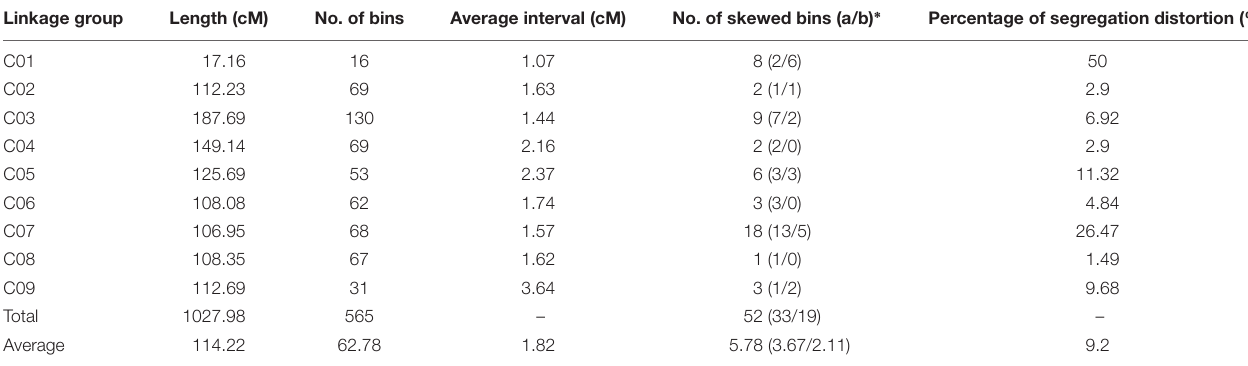
TABLE 3 | Overview of bins on the nine linkage groups of Brassica oleracea. Linkage